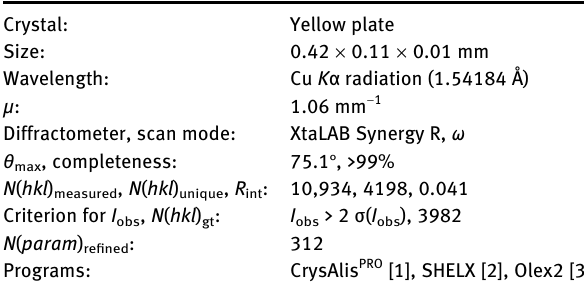
Table 1 contains crystallographic data and Table 2 contains the list of the atoms including atomic coordinates and displacement parameters.